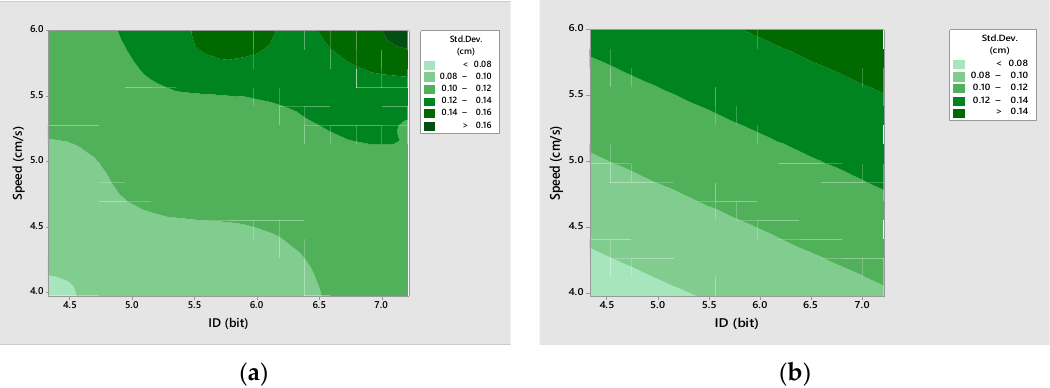
Figure 3. Standard deviation of the endpoint position (SD) observed ([19], ( a )) and predicted (model Equation (5), ( b )) vs. ID (Equation (8)) and observed task speed.